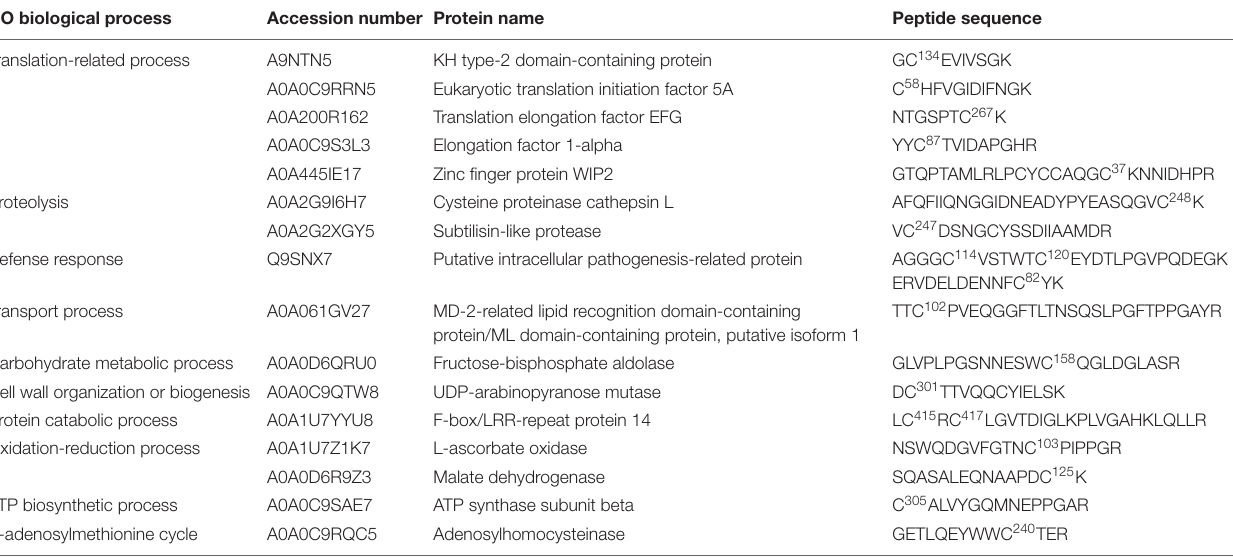
TABLE 1 | Putative S -nitrosated proteins and cysteines sites identified by iodo-TMT reagent from GSNO-treated crude extracts of cell line Y1, after 2 weeks of cultivation on proliferation medium MSG (Becwar et al., 1989) supplemented with sucrose and solidified with 0.3% (w/v) Gellan gum. GO biological process